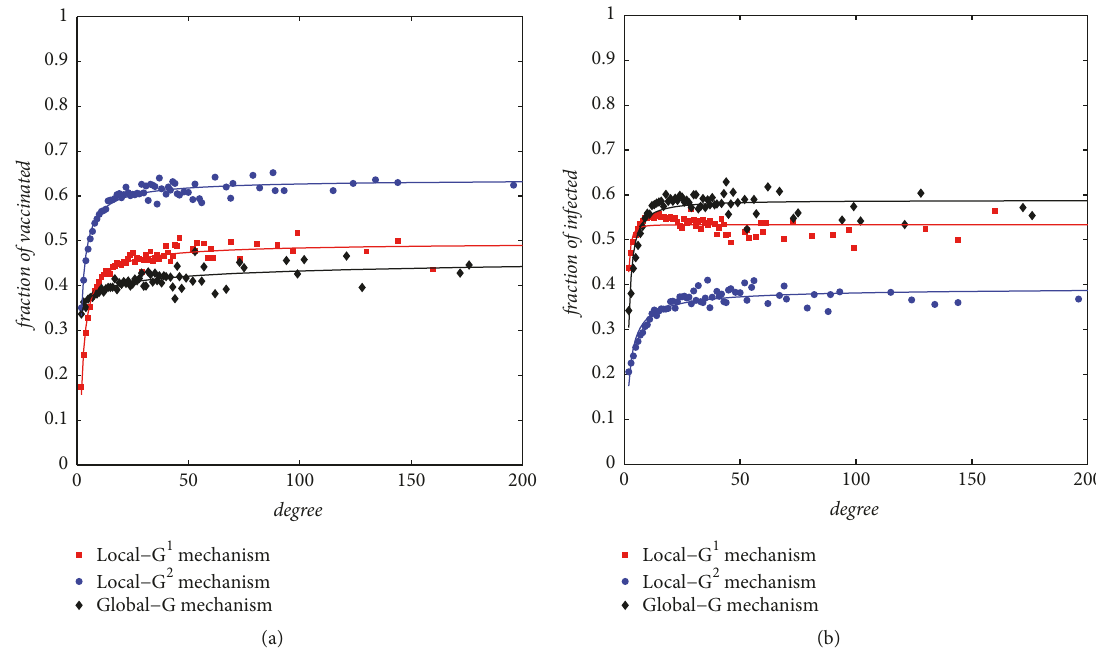
Figure 3: The fraction of vaccinated and infected individuals with different degrees under different decision-making mechanisms. The simulations are carried out in scale-free networks with network size 𝑁 = 10,000 and average degree ⟨𝑘⟩ = 4 . The relative cost is set to be 𝑐 = 0.5 . The results are based on the last 500 epidemic seasons.